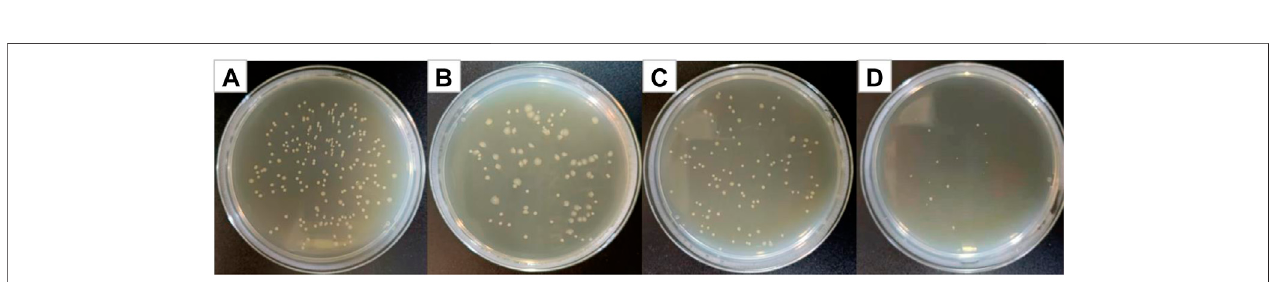
Frontiers in Chemistry |